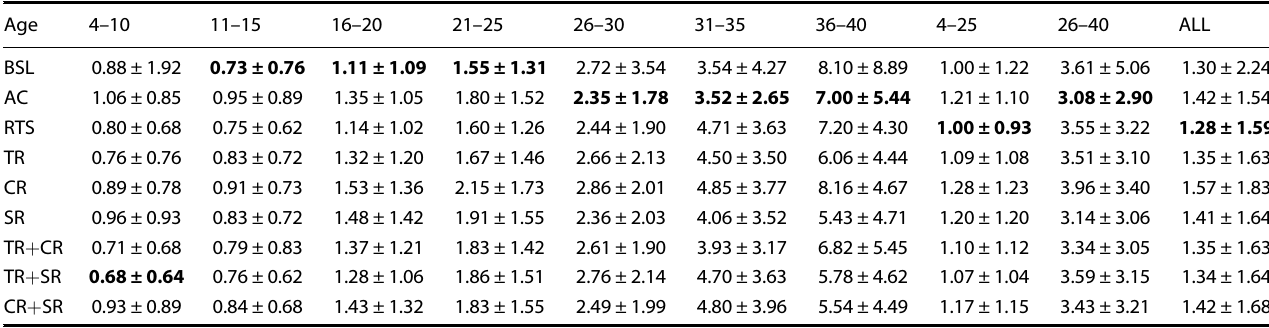
Table 1. Tabulated measurements results of the mean of absolute error (MAE) ± standard deviation of the absolute error (SD)